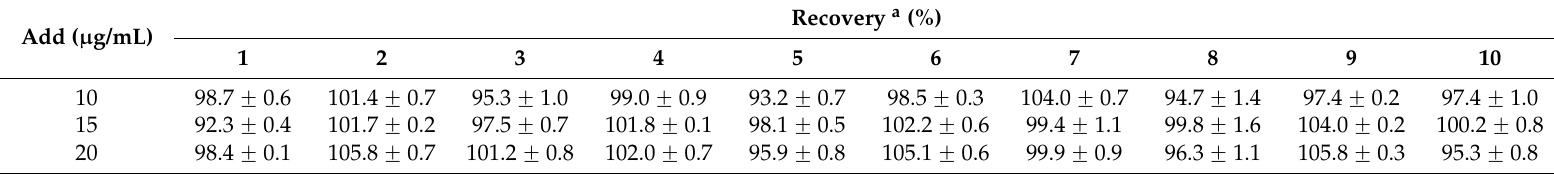
Table 4. Recoveries for alkaloids ( 1 – 10 ) from lotus flower.